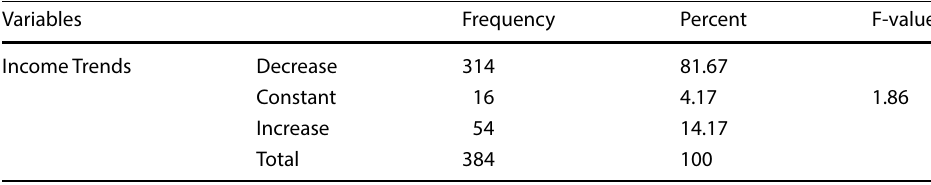
Table 4 Income trends of sample